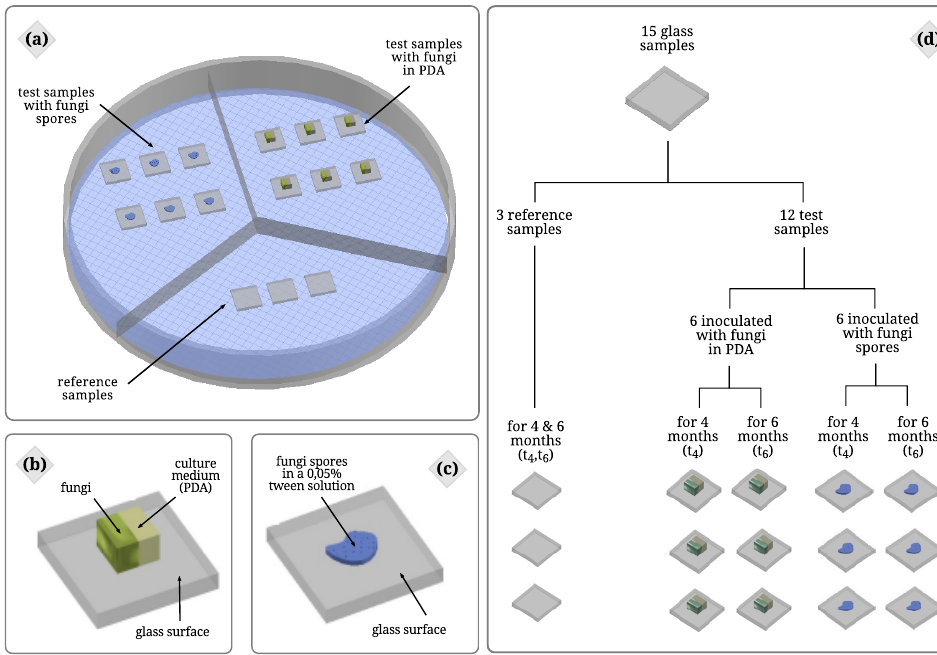
Figure 1. Experimental design ( a ) Petri dish with glass samples (includes reference samples, samples inoculated with fungal spores ( b ) and samples inoculated with PDA ( c ). Glass biodeterioration experiment design and sample number ( d